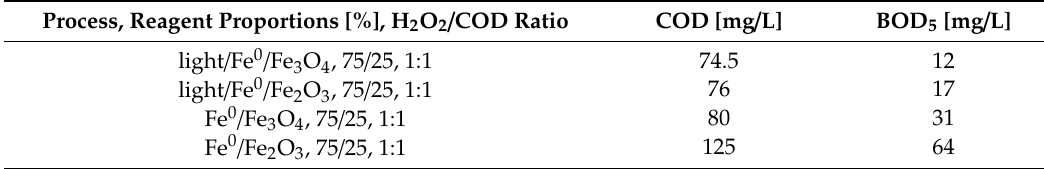
Table 2. Parameters of wastewater after advanced oxidation processes (AOP)